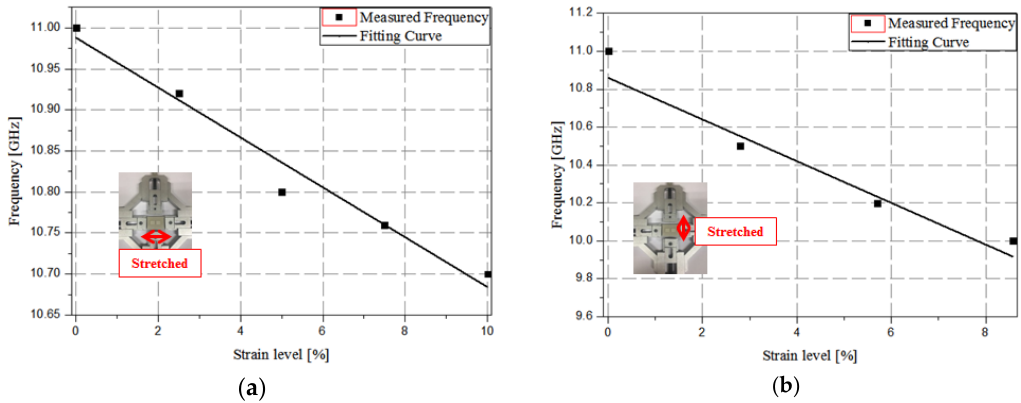
Figure 10. Relation between the resonant frequency and strain level along ( a ) the x -direction and ( b ) the y -direction.